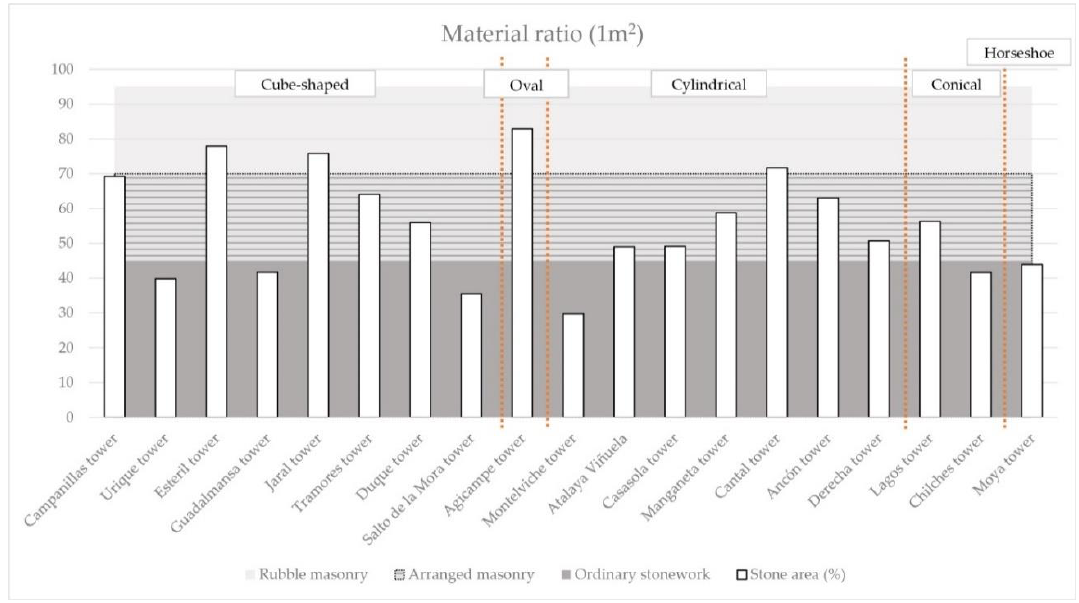
Figure 13. Graph showing the percentage of masonry in each elevation and possible classification of construction systems according to the ratio of materials in masonry constructions.